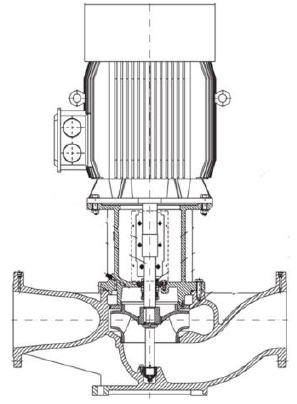
Figure 18. Illustration of the experiment pump (vertical pipe pump) [79].